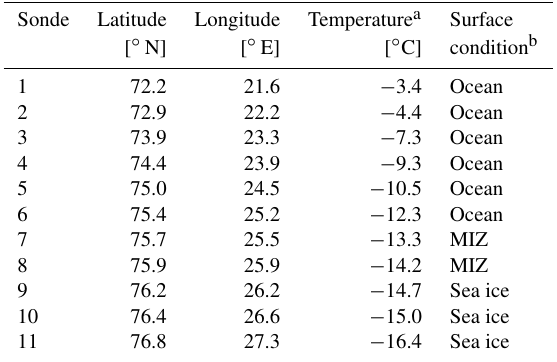
Table 1. Key dropsonde information.